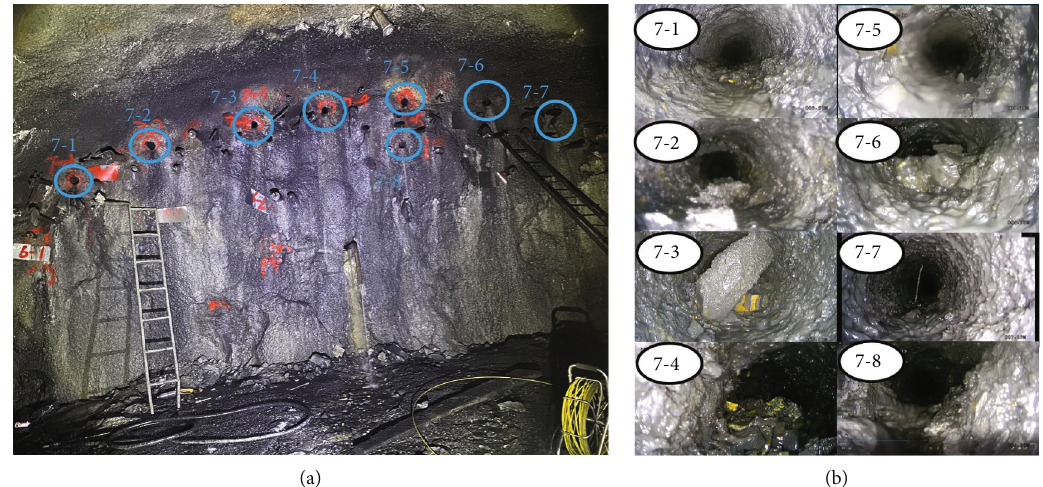
Figure 4: The layout and imaging results of last drills: (a) layout and (b) imaging